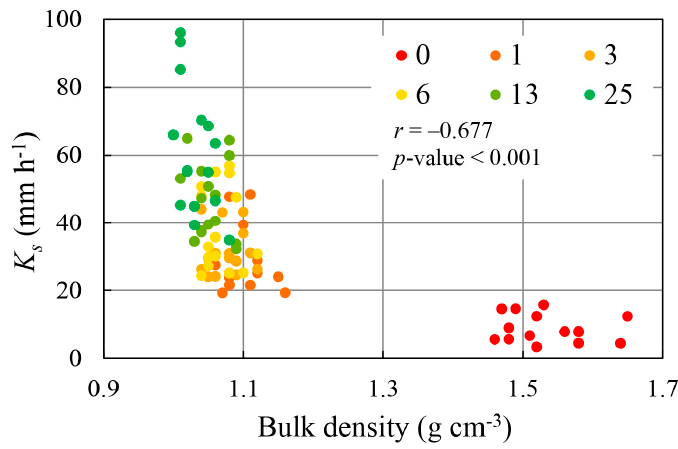
Figure 5. Correlation between the soil bulk density (g cm − 3 ) and field saturated soil hydraulic conductivity, K s (mm h − 1 ). Pearson’s correlation coefficients ( r ) and probability of error ( p ) are reported.